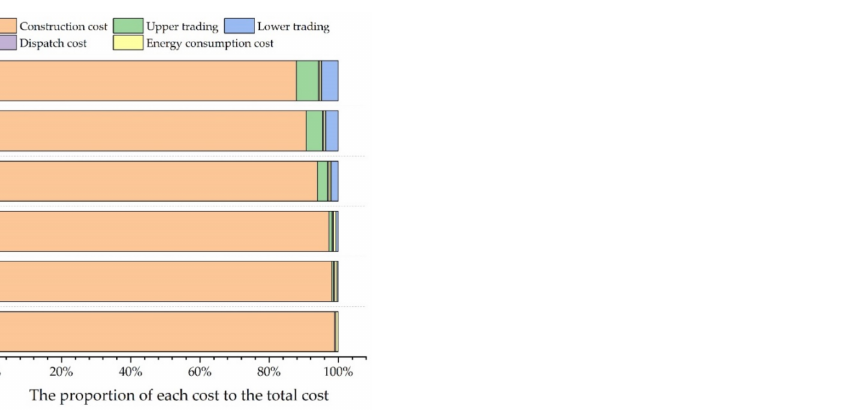
Figure 14. The relation between the proportion of each cost and carbon trading price when the carbon emission cap is 1000